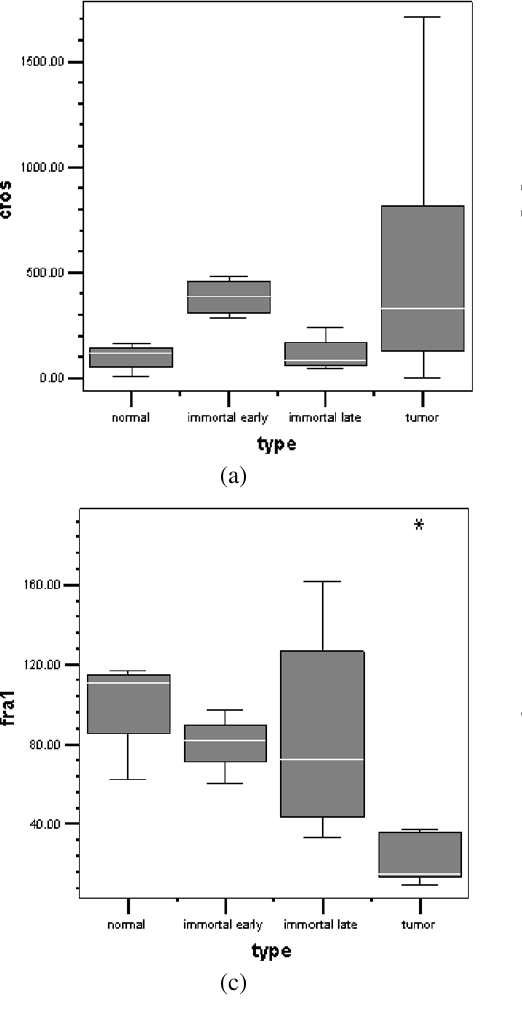
Fig. 1. Real-time RT-PCR results for c-Fos (a), Fra-2 (b), Fra-1 (c), c-Jun (d), JunB (e), Net (f), Notch1 (g), and CADM1 (h) in primary keratinocytes (normal) ( N = 5), early passages of HPV-immortalized cell lines (immortal early N = 4), late passages of HPV-immortalized cell lines (immortal late N = 4), and cervical carcinoma cell lines (tumor N = 7). For cell populations representing the different stages of transformation boxplots of the mRNA levels relative to the housekeeping gene snRNP are shown, in which the relative mRNA expression in primary keratinocytes are set to 100%. Grey boxes represent the middle 50% of the data: the 25th percentile to the 75th percentile. The white lines in these grey boxes represent the median. The whiskers represent the highest and the lowest values, asterixes represent any